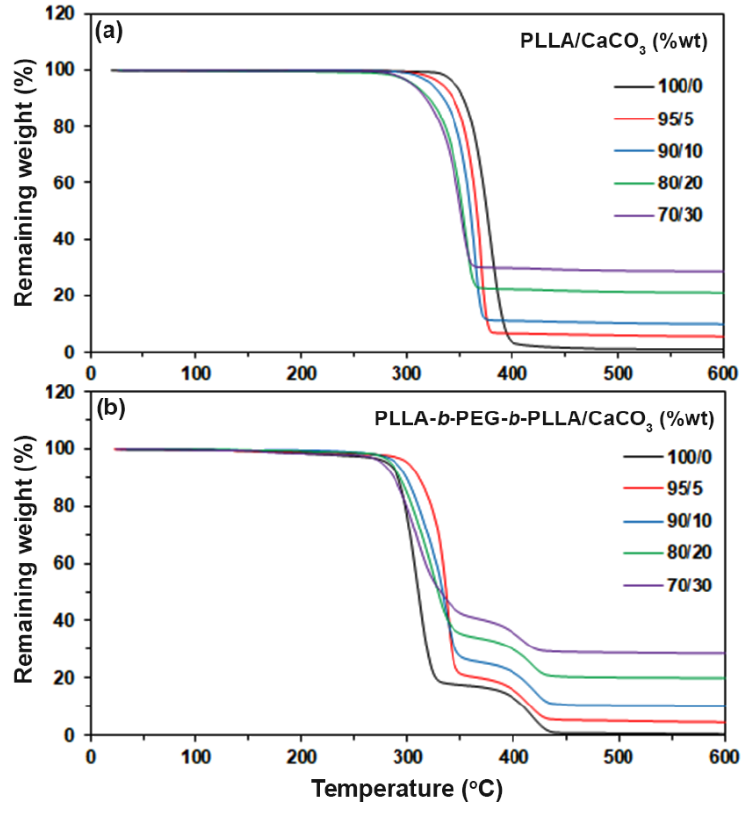
Figure 5. TG thermograms of ( a ) PLLA/CaCO 3 and ( b ) PLLA- b -PEG- b -PLLA/CaCO 3 composites with various CaCO 3 ratios.